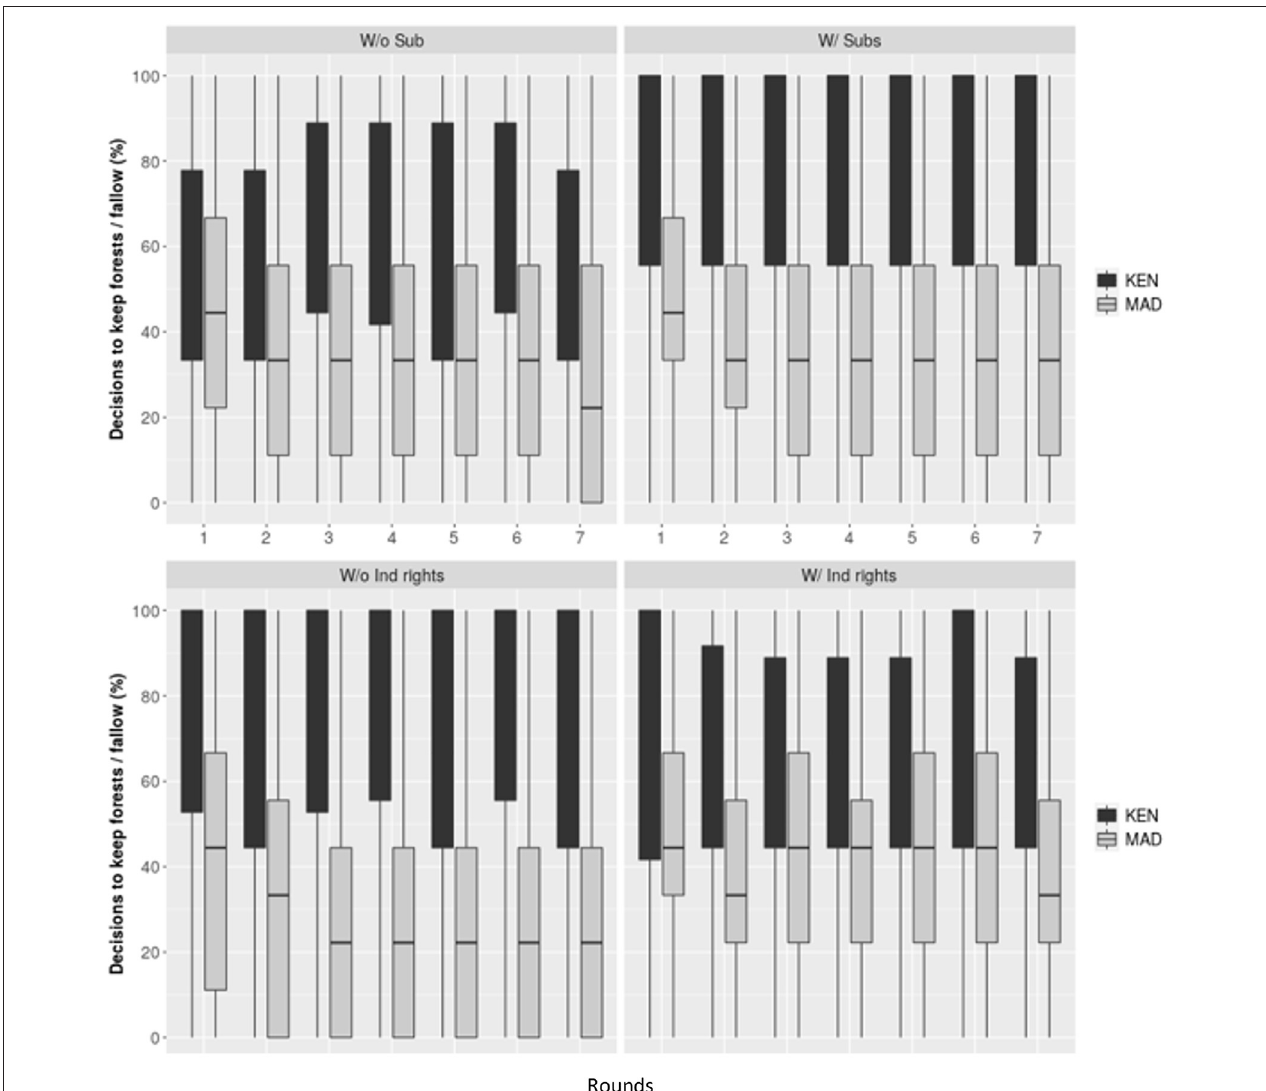
FIGURE 4 | Distribution of mean observed percentages of decisions to keep forest/fallow in the treatments and rounds (Subsidy takes a value of 1 if there is subsidy, 0 otherwise, and same with individual rights) across households and groups. The median marks the midpoint of the data and is shown by the line that divides the box into two parts. The box represents the middle 50% of percentages of decisions to keep